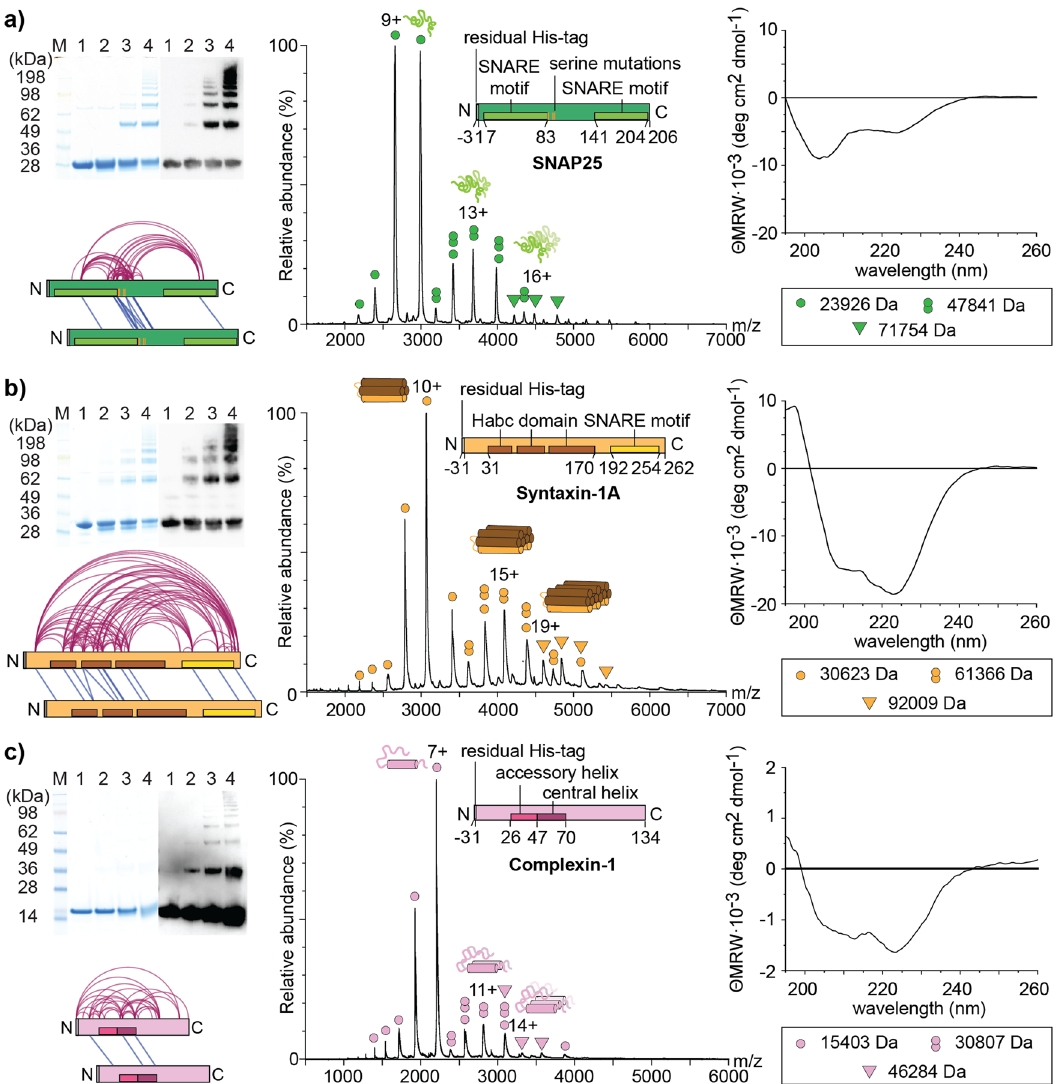
Fig. 1 Multimerisation of SNAP25, Syntaxin-1A and Complexin-1. Left panels: 10 µ M of each protein were cross-linked with 0 mM (lane 1), 0.5 mM (lane 2), 1 mM (lane 3) and 1.5 mM (lane 4) BS3 cross-linker. Cross-linked and non-cross-linked proteins were separated by gel electrophoresis and visualised by Coomassie staining and western blot detection using anti-SNAP25, anti-Syntaxin-1A or anti-Complexin-1 antibodies, respectively. Uncropped gel and western blot images are provided in Supplementary Figure 1. For identi fi cation of cross-links, 10 μ M of SNAP25 or Syntaxin-1A as well as 50 μ M Complexin-1 were cross-linked with 150- or 10-fold molar excess of BS3. Cross-links identi fi ed in at least two replicates are visualized in network plots. The bars correspond to the size of the proteins. Helical structures, SNARE motifs and N-/C-termini are indicated. Middle panels: 10 µ M of each protein were analysed by native MS. Charge state distributions corresponding to monomers (circle), dimers (twin-circles) and trimers (triangle) are assigned in the mass spectra. Right panels: CD spectra acquired from 30 µ M protein. a SNAP25. b Syntaxin-1A. c